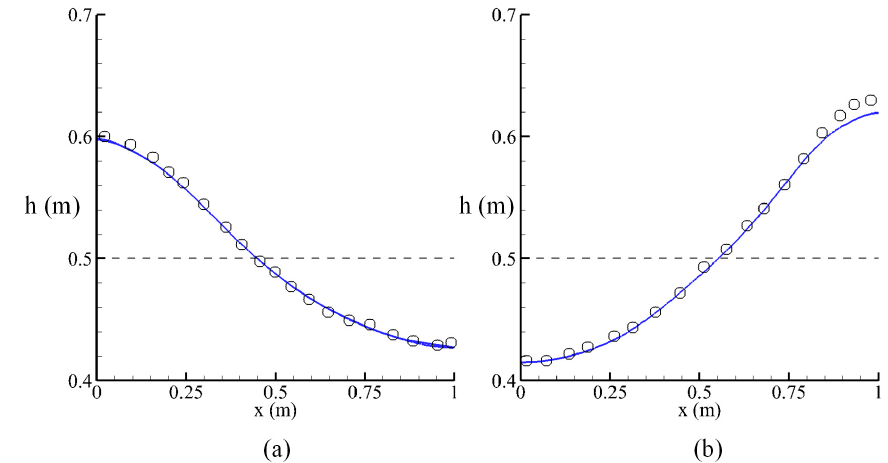
Figure 2. Comparison of the calculated free-surface profile with the experimental measurements at different time values: ( a ) t = 2.95 s and ( b ) t = 3.55 s. Continuous lines represent the present numerical results, circles represent the measurements of Okamoto and Kawahara (1990), and the dashed line represents the initial water level in the tank.